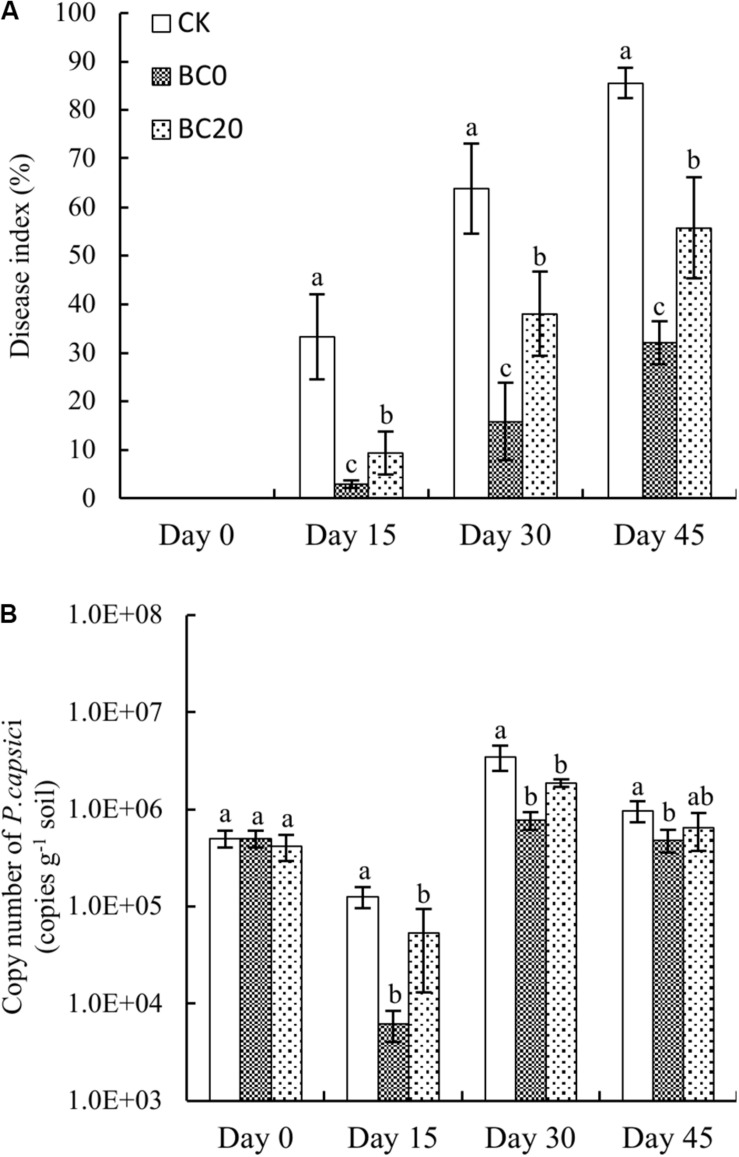
Temporal effects of biochar applied at different times on the disease index (A) and abundance of Phytophthora capsici
(B) during the growing period. Bars represent average values ± standard error. Different letters above columns indicate significant differences (p < 0.05) according to one-way ANOVA (n = 3).